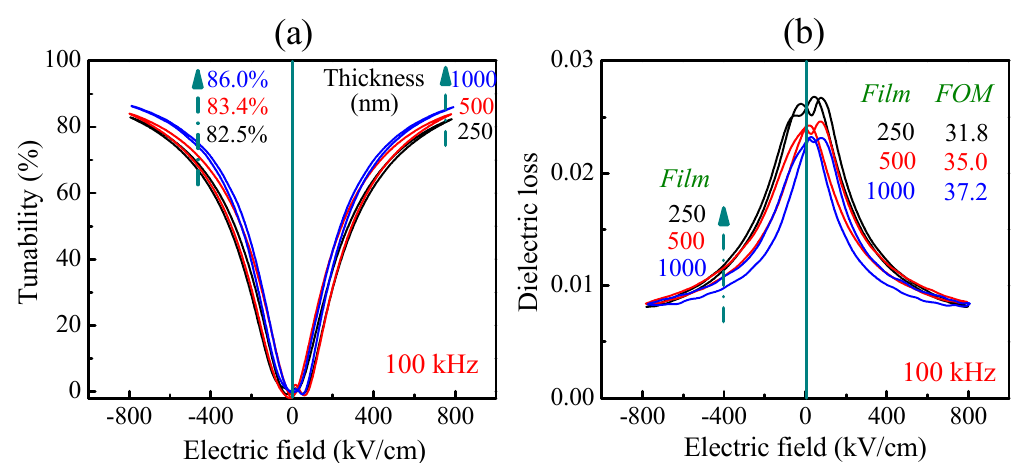
Figure 2. Dielectric constant–electric field ( ε - E ) curves of ( a ) 250-nm, ( b ) 500-nm and ( c ) 1000-nm PLZT films, as a function of frequency. ( d ) Comparison of ε - E curves of PLZT films measured at 100 kHz. The measurements were performed at 800 kV/cm.